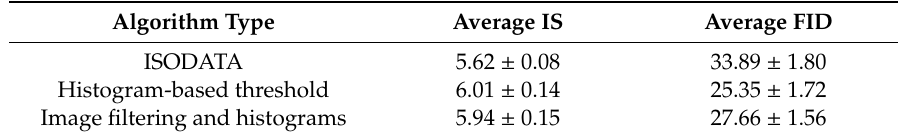
Table A4. We compared the inception score (IS) and Fr é chet inception distance (FID) of the generated images in di ff erent image binarization algorithm. We compared the ISODATA, histogram-based threshold, and image filtering and histogram. We gathered statistics for 10 training exercises, and the di ff erence was statistically significant ( p < 0.05).